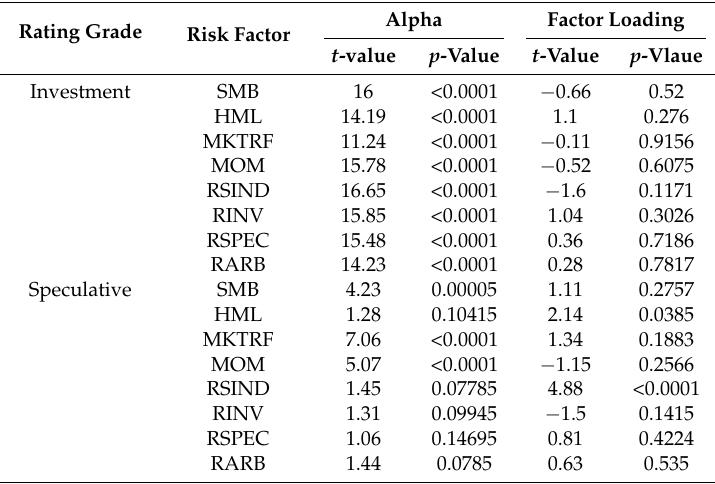
Table 7. Market Neutrality of